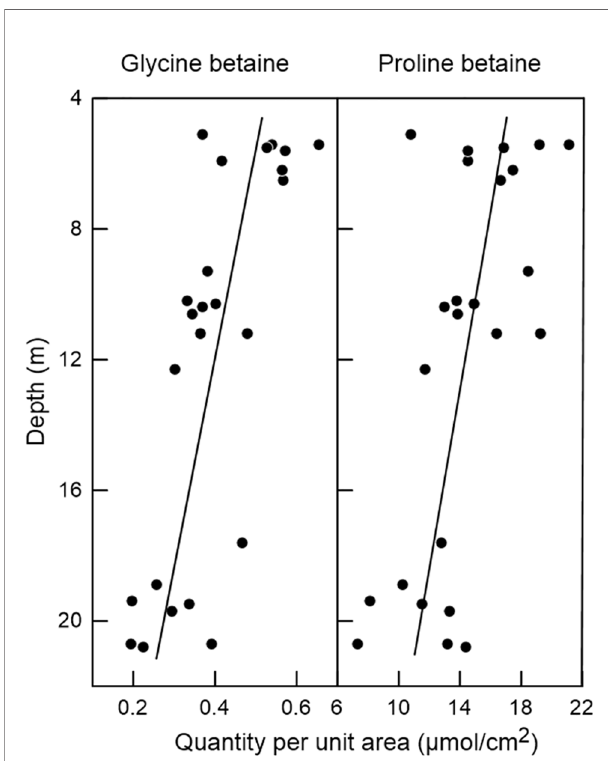
FIGURE 2 | Abundance of glycine betaine and proline betaine in the tissues of Madracis mirabilis as a function of depth of residence. Each symbol is for a single, separate coral colony. All colonies grew in fully exposed, unshaded locations. Lines were fi tted by least-squares regression. Based on ANOVA, differences among depths are statistically signi fi cant (p < 0.05). Betaine abundance is expressed as a ratio of the coral surface area sampled. (Data from Hill et al.,